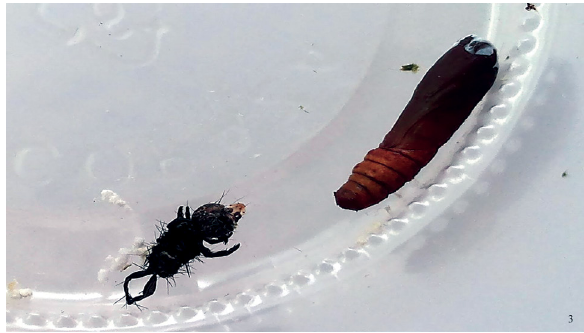
Figure 2. Pupae and exuvia of Selenisa sueroides (Guenée, 1852) (Lepidoptera: